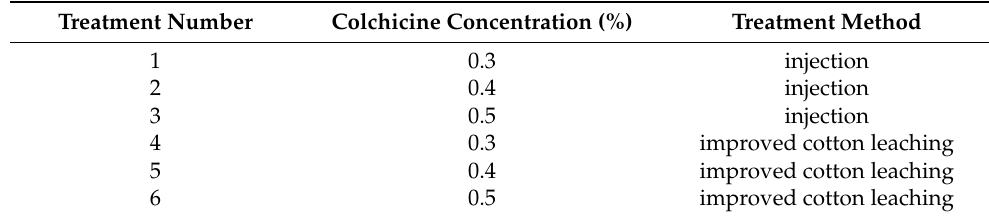
Table 1. The treatment of colchicine concentration and application method.